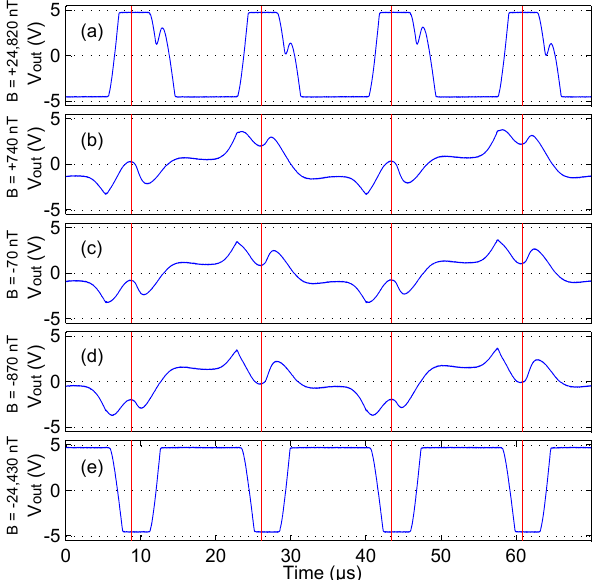
Fig. 6. V out at various applied magnetic fields that are (a) large positive ( + 24820 ± 10nT), (b) small positive ( + 740 ± 10nT), (c) near zero ( − 70 ± 10nT), (d) small negative ( − 870 ± 10nT), and (e) large negative ( − 24430 ±